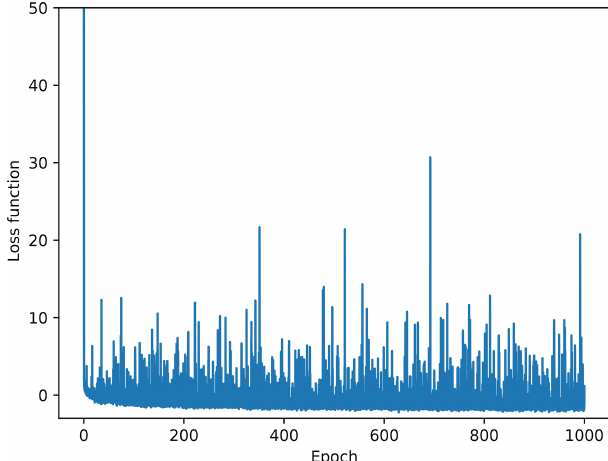
Figure 3. RMSE difference with cross-validation dataset as a func- tion of iteration. The solid blue line represents the DINCAE recon- struction at different steps of the iterative minimization algorithm. The dashed cyan line is the DINEOF reconstruction and the dashed red line is the average DINCAE reconstruction between epochs 200 and